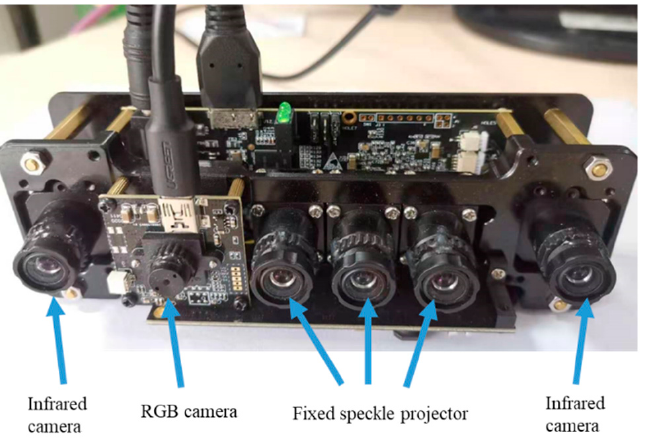
Figure 8. Three-dimensional face acquisition device via three fixed-speckle projections.